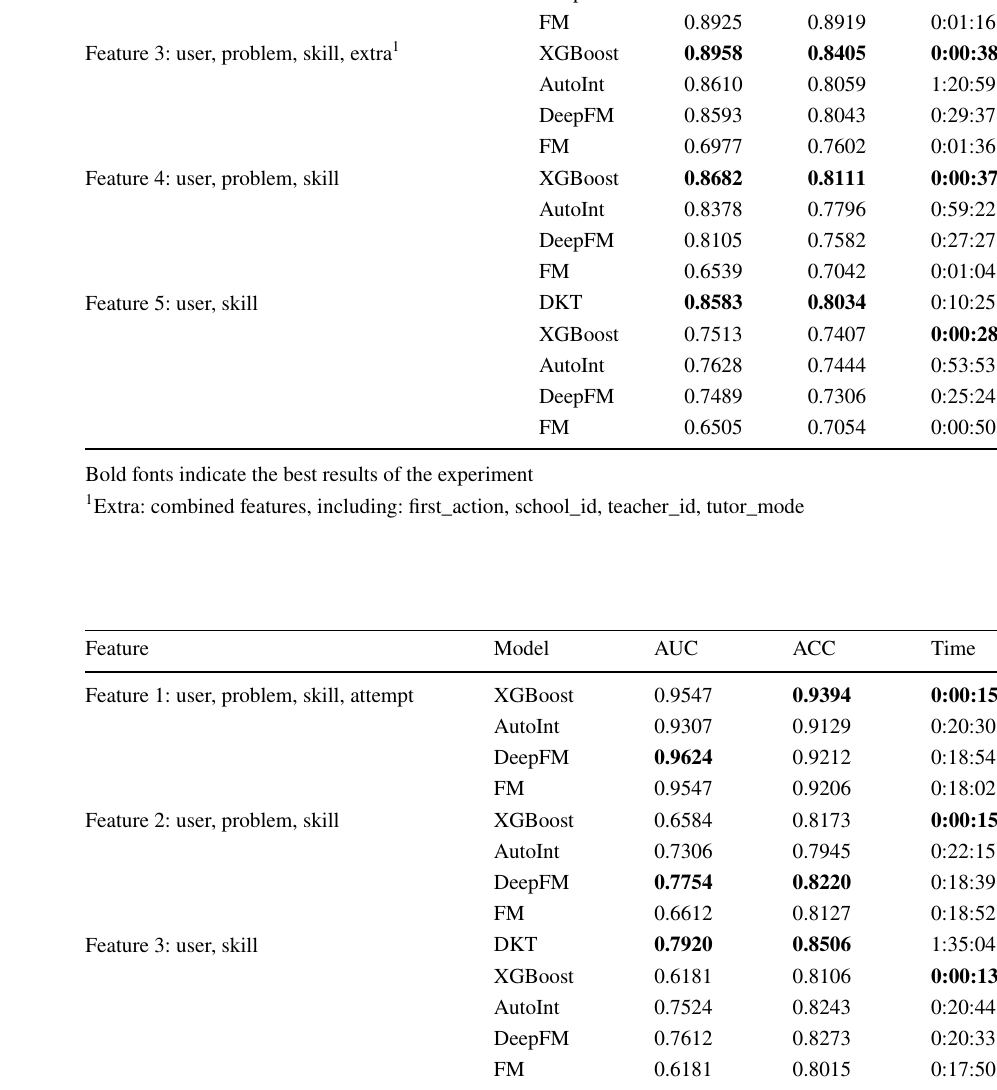
Bold fonts indicate the best results of